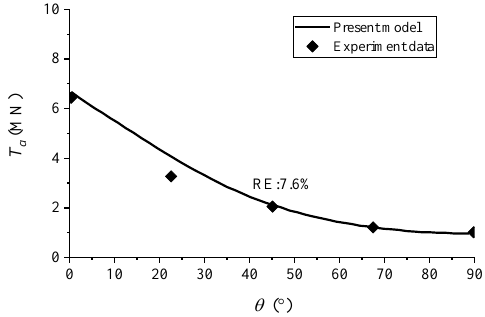
Figure 10. Comparative study based on centrifuge tests presented by Kim et al. [35,46].